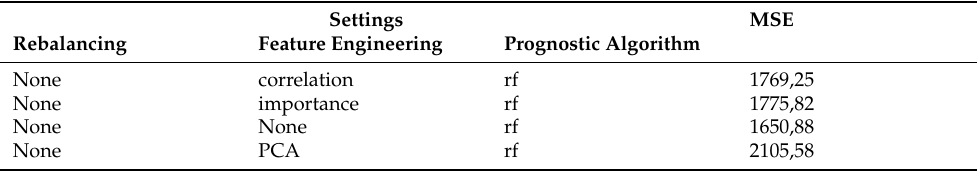
Table 10. A comparison of applying different feature engineering methodologies and the resulting MSEs on dataset